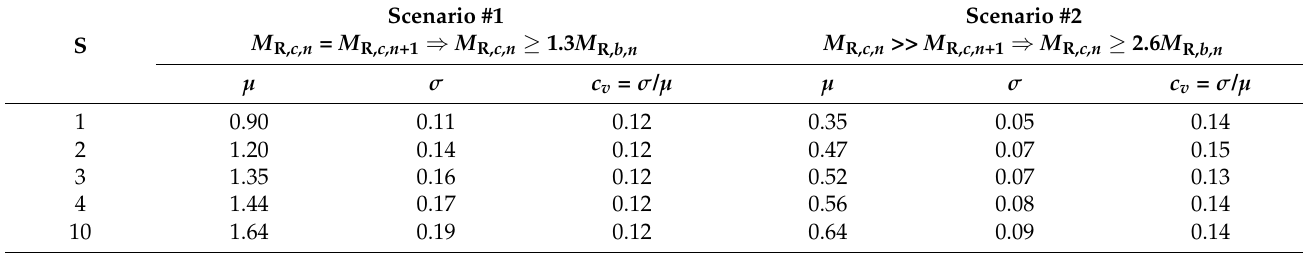
Figure A1. Original and surrogate frame: ( a ) original frame definition; ( b ) surrogate frame used in study; ( c ) capacity condition at joints. Table A1. Summary statistics of λ assuming IPE beams and HEB columns with equal yield strength, according to number of bays S and relative column strength scenarios.